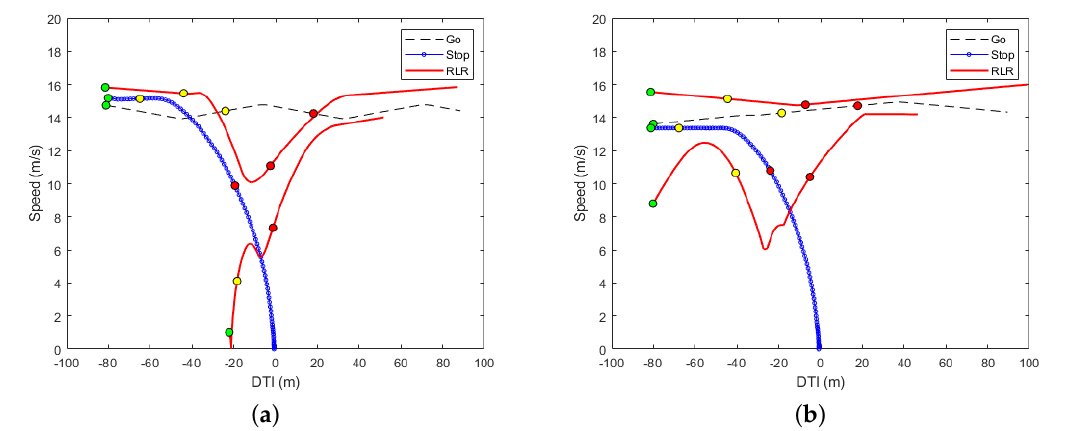
Figure 5. Comparison of vehicle reaction pattern between continuous decision model and one decision model where colored circles in the images indicate the traffic light signals. ( a ) Examples of velocity profiles with continuous decision model; ( b ) Examples of velocity profiles with one decision